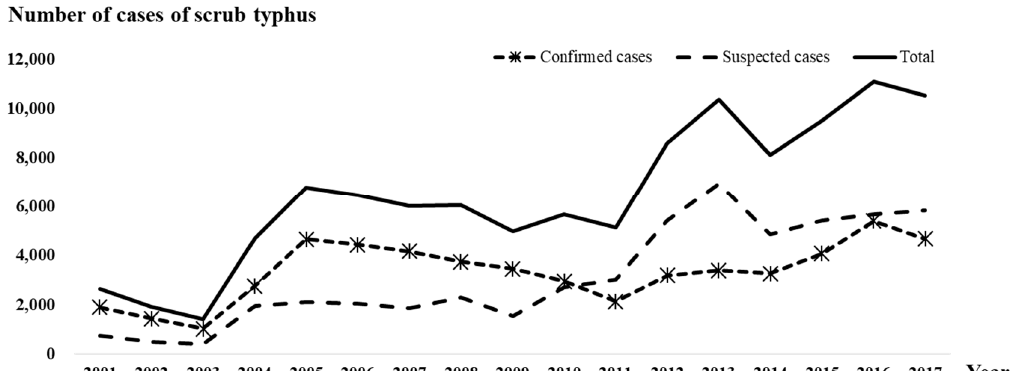
Figure 1. The number of cases of scrub typhus reported annually in Korea.